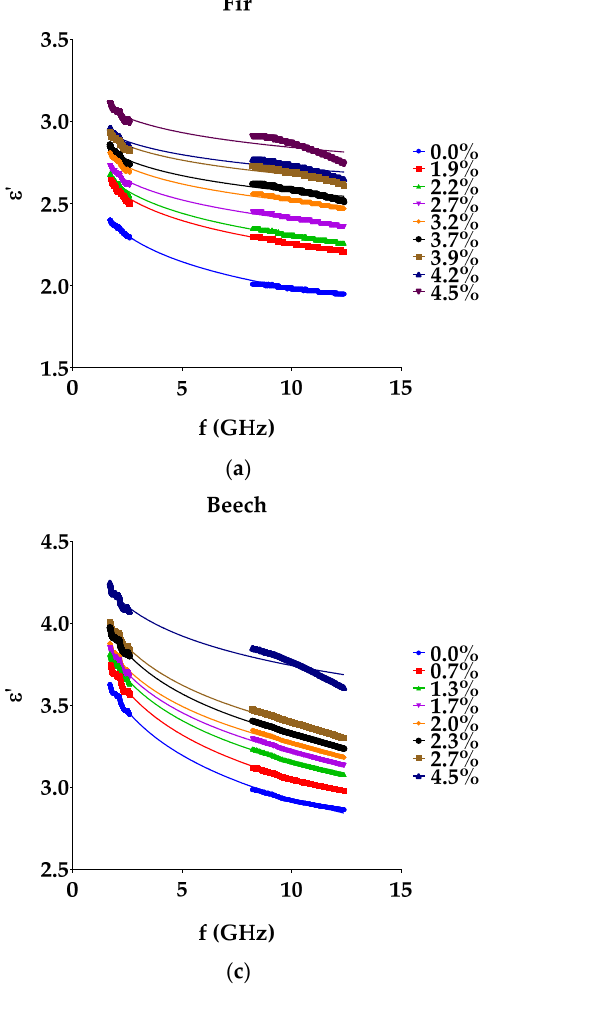
Figure 4. This figure reports the relations between ε ’ and frequency f for the different water content θ v with highlighted the log-fit: ( a ) fir ε ’ – f relationship; ( b ) poplar ε ’ – f relationship; ( c ) beech ε ’ – f relationship; ( d ) oak ε ’ – f relationship. Measurements were conducted with WR-430 and WR-90 waveguides. Table 1. Log-fit parameters and coefficient of determination for the wood samples at different levels of water content.